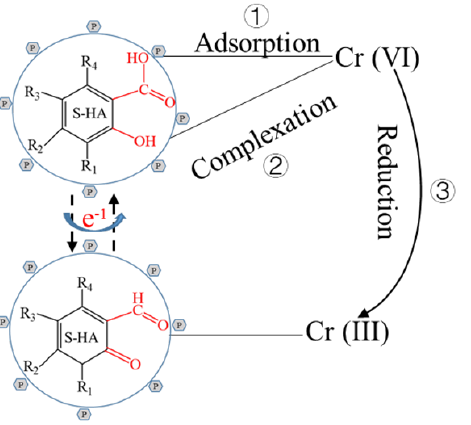
Figure 6. The mechanism of Cr (VI) adsorption and reduction by struvite – humic acid composite.